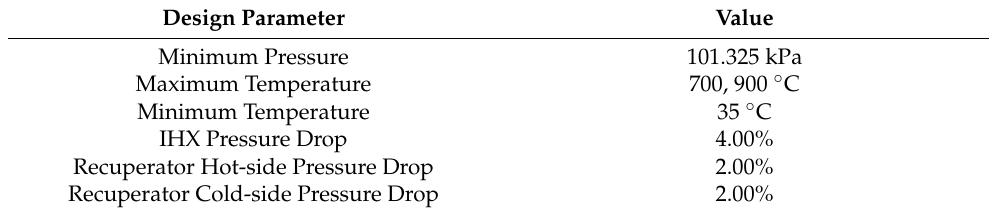
Table 2. Design Value for air Brayton